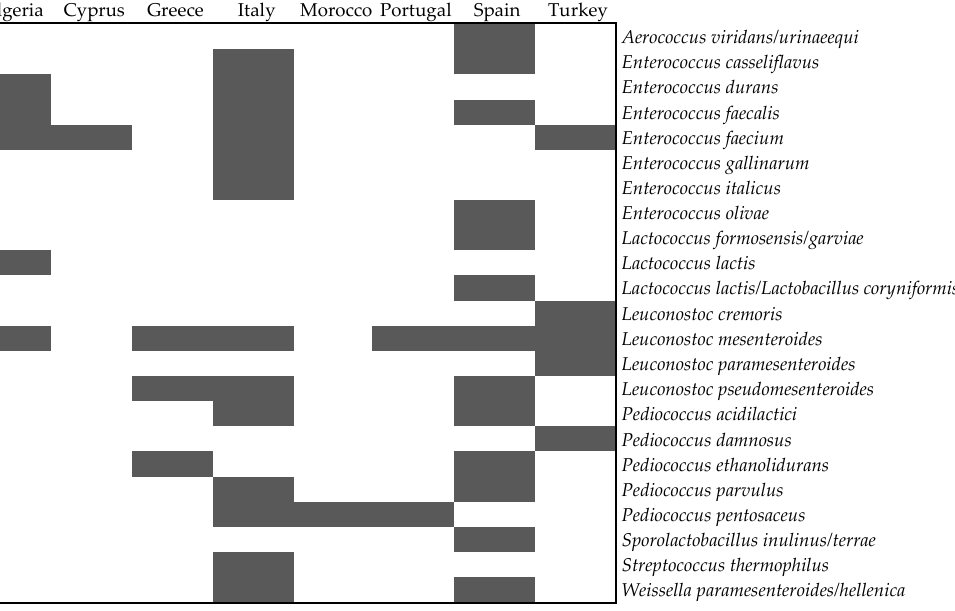
Figure 9. Geographic origin of identified LAB ( Lactobacillus spp. excepted) from table olives. Grey indicates presence of species, and white indicates absence thereof.